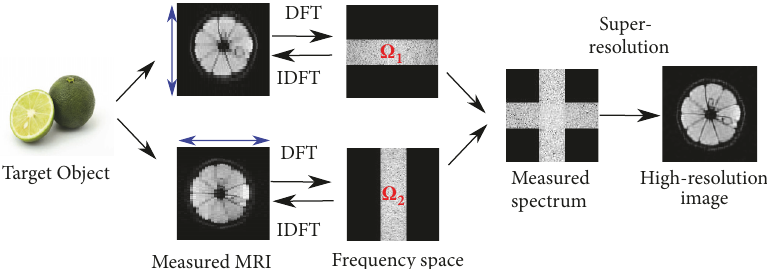
Figure 1: Flow of MR image acquisition and super-resolution. The specimen is measured anisotropically from different directions. The blue arrows denote the through-slice directions. MR images are obtained with a narrow bandwidth along the through-slice directions. In most MR images, the spatial resolution along the through-slice direction is more than three times lower than that in the other two directions. There are still unknown high-frequency components even when a number of measurements are available. These components are completed by